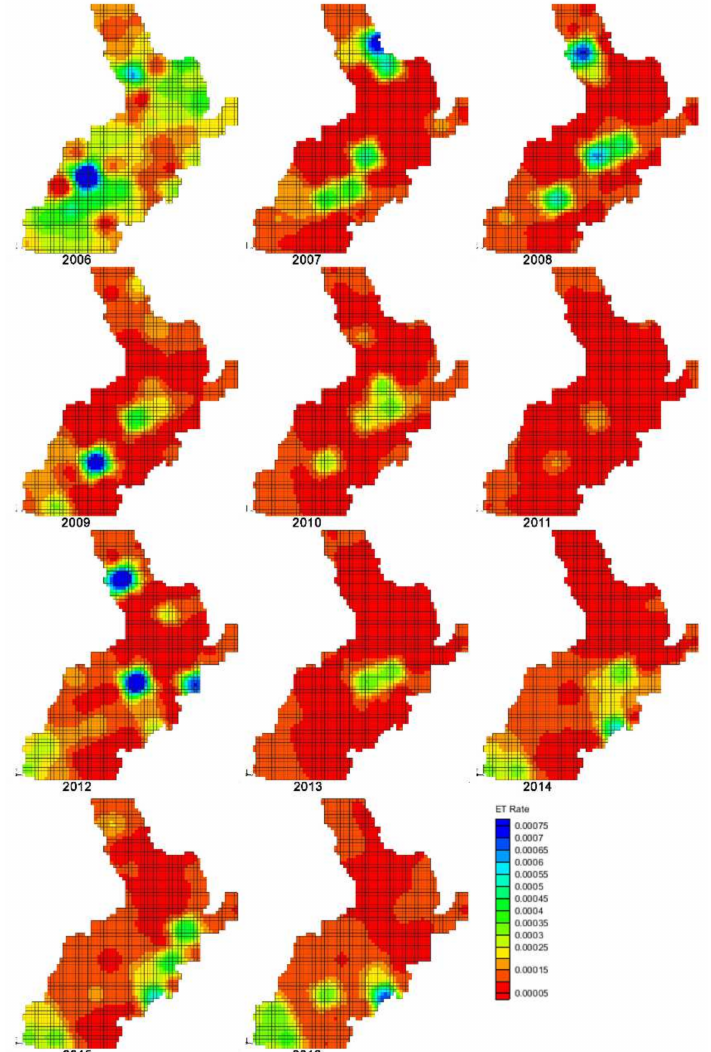
Figure 15. Spatial distribution of evapotranspiration after model calibration.